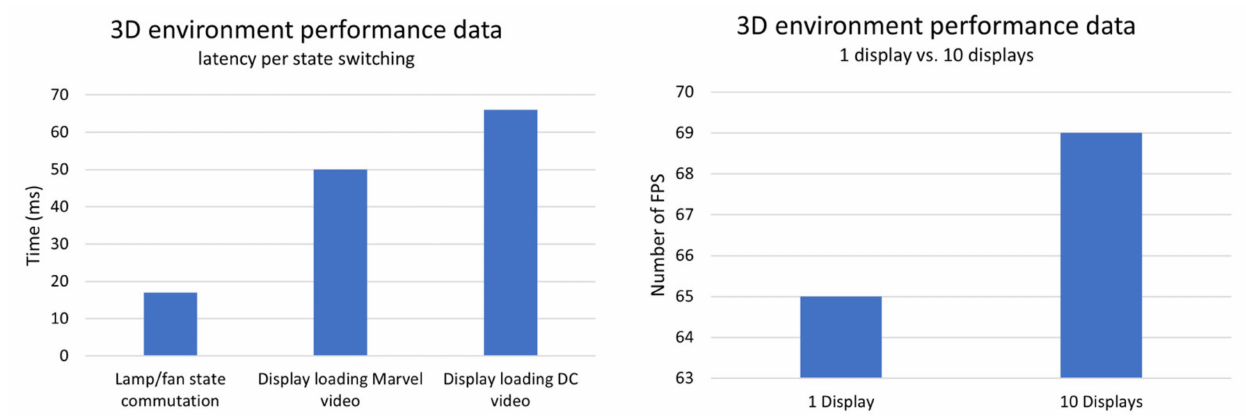
Figure 12. Three-dimensional environment performance assessment: the left plot shows the time required for 3D endpoints (lamp, fan and display) state switching, while in the one placed at the right, the performance impact (in FPS) of having a single display running a video vs. 10 more of them in the same conditions is presented. Table 9. Specifications of the videos used in the proposed IoT simulation tool.